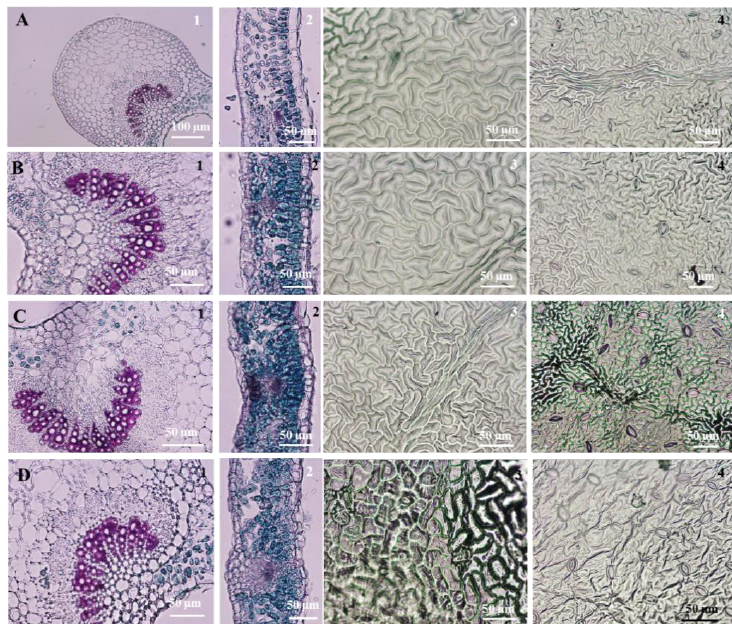
Figure 6. Cross sections of leaves in peach hybrids under ex vitro acclimatization for 15 days: ( 1 ) central vein, ( 2 ) leaf and casts of their integumentary tissues ( 3 ) adaxial epidermis, ( 4 ) abaxial epidermis). ( A ) ‘Clyde Wilson’ × ‘Nikitskiy Podarok’, ( B ) ‘Jerseyglo’ × ‘Nikitskiy Podarok’, ( C ) ‘Loadel’ × ‘Nikitskiy Podarok’, ( D ) ‘Summerglo’ × ‘Nikitskiy Podarok’. Bars = 50 µm.